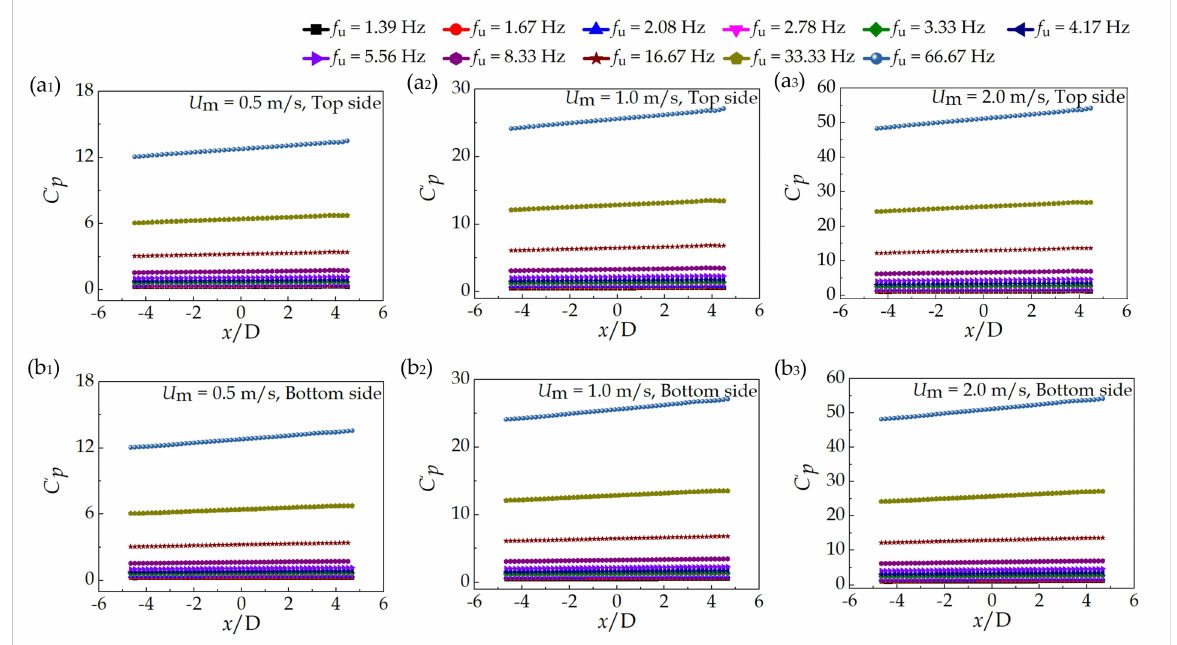
Figure 6. RMS pressure coefficients with different f u and U m values in streamwise sinusoidal oscillating flows: ( a 1 ) U m = 0.5 m/s, top side; ( a 2 ) U m = 1.0 m/s, top side; ( a 3 ) U m = 2.0 m/s, top side; ( b 1 ) U m = 0.5 m/s, bottom side; ( b 2 ) U m = 1.0 m/s, bottom side; ( b 3 ) U m = 2.0 m/s, bottom